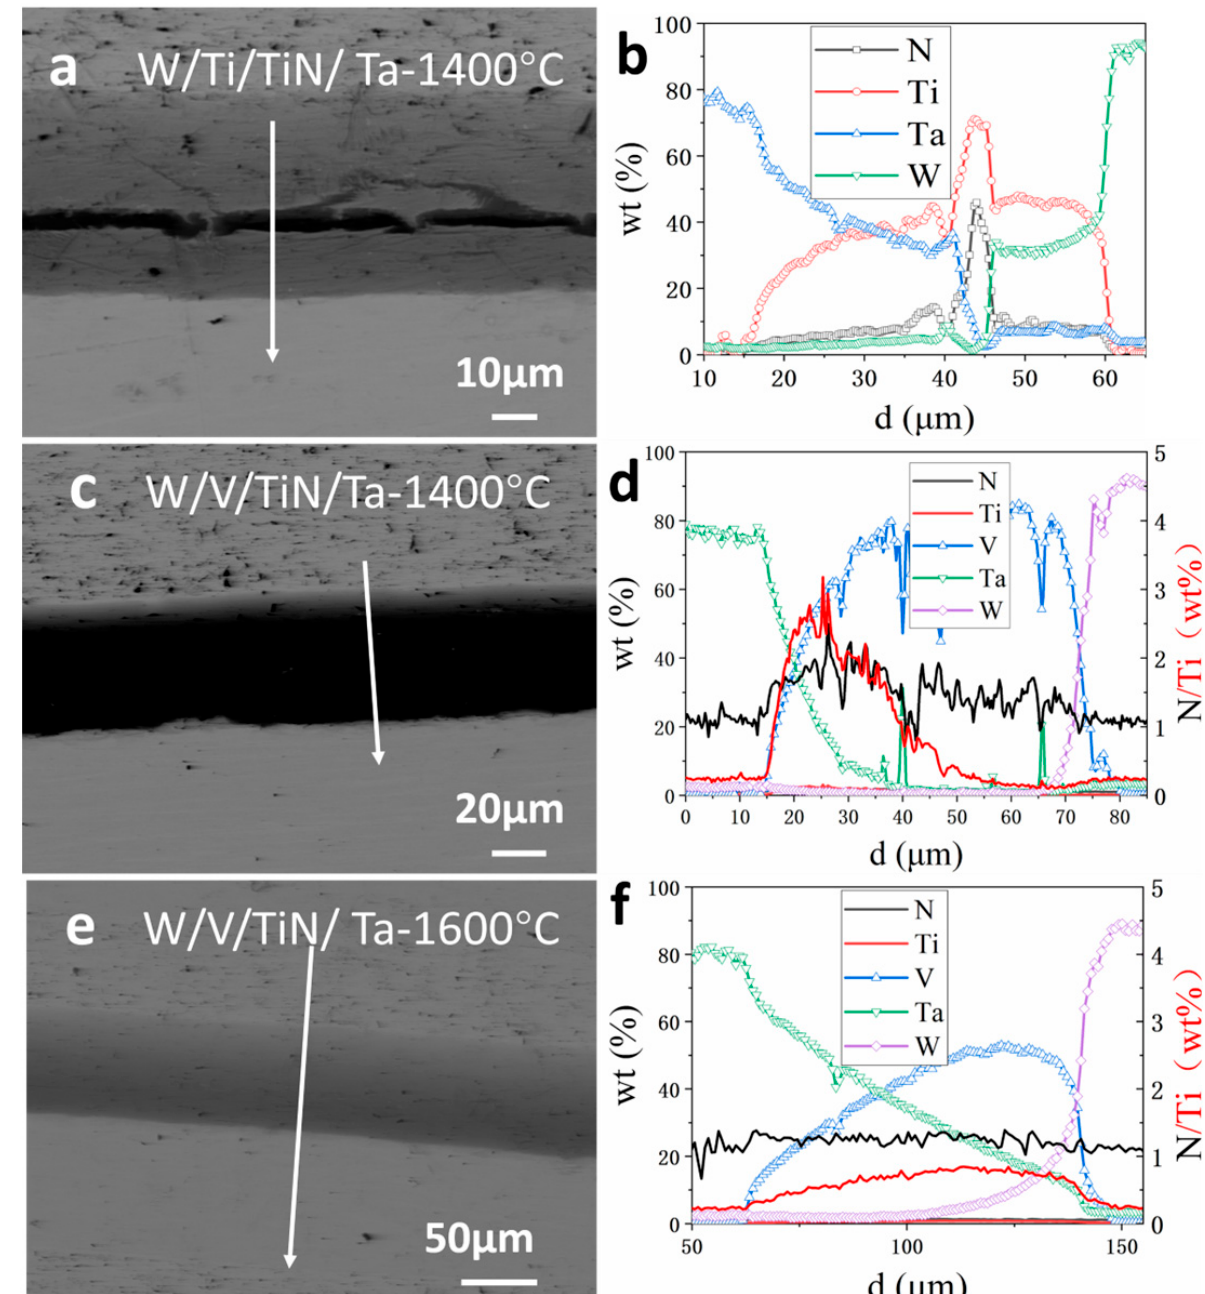
Figure 12. Element distribution near the interface of W/M/TiN/Ta-laminated composites: ( a , b ) W/Ti/TiN/Ta (joined at 1400 °C); ( c , d ) W/V/TiN/Ta (joined at 1400 °C); and ( e , f ) W/V/TiN/Ta (joined at 1600 °C).